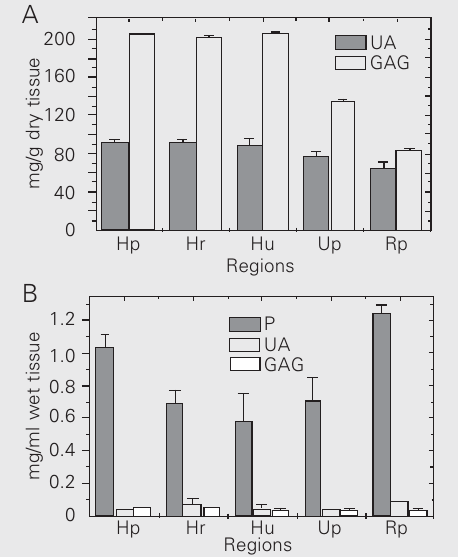
Figure 2. A , Hexuronic acid and sulfated glycosaminoglycan content of papain-treated tissue samples. Mean values are re- ported as mg/g dry tissue. B , Protein, uronic acid, and sulfated glycosaminoglycan content of D4 fractions after centrifugation on a CsCl gradient. Mean values are reported as mg/ml wet tis- sue. ANOVA with Fisher distri- bution (P < 0.05) indicated varia- bility among means. P = pro- tein; UA = uronic acid; GAG = sulfated glycosaminoglycans. For abbreviations, see legend to Figure